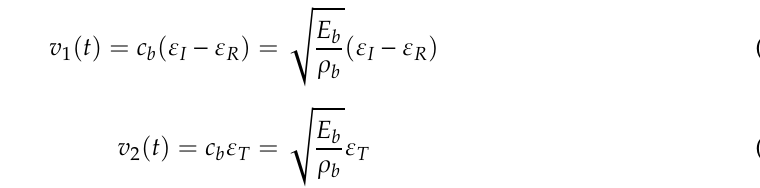
Figure 5. Strength of brittle materials affected by strain-rate (redrawn from Qi et al. [38]).